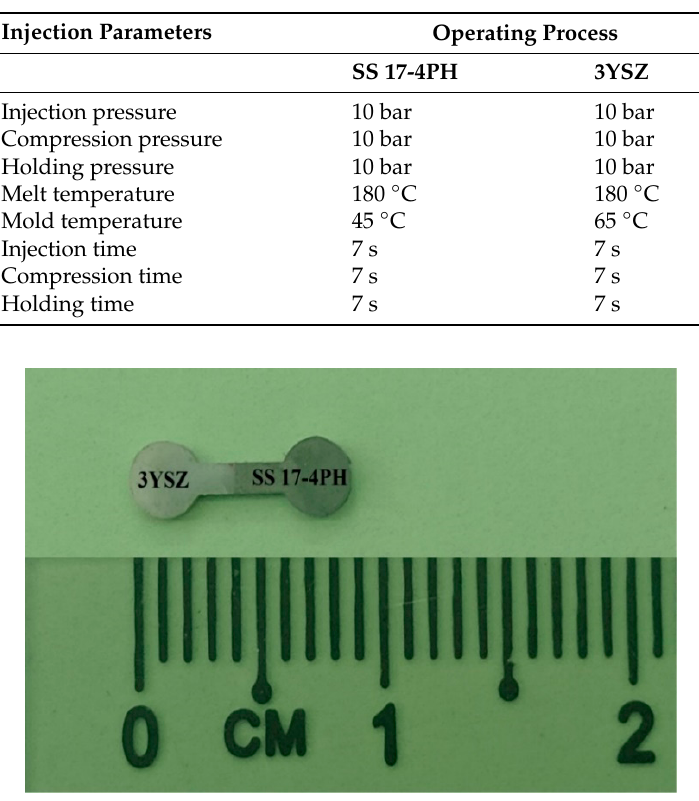
Table 3. Injection molding parameters to produce SS 17-4PH and 3YSZ micro-parts.